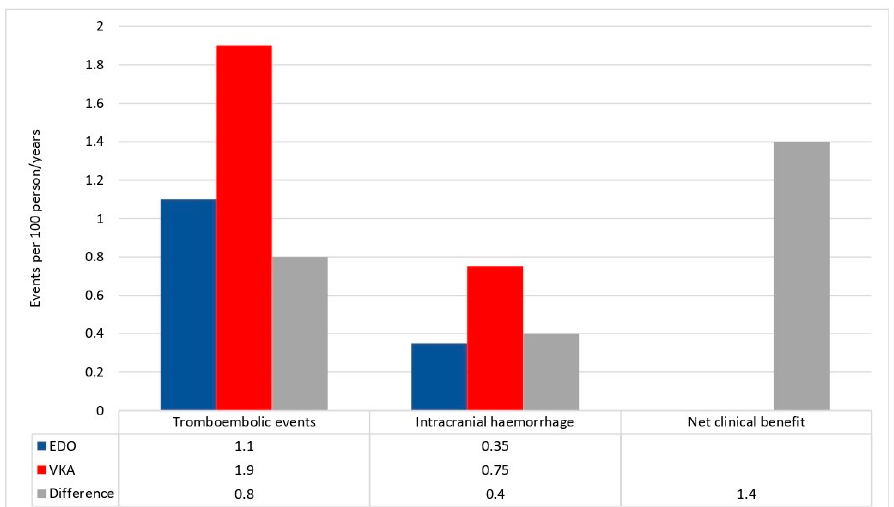
Figure 1. Incidence rates of thromboembolic events and intracranial hemorrhage in Edoxaban (EDO) and vitamin K antagonist (VKA) recipients. Differences ( Δ ) between incidence rates were used to calculate the net clinical benefit (NCB).